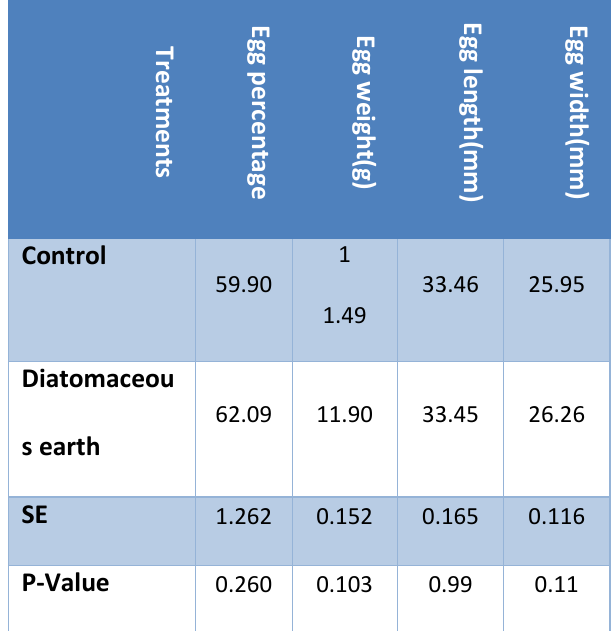
Table, 5: Evaluation of diatomaceous earth